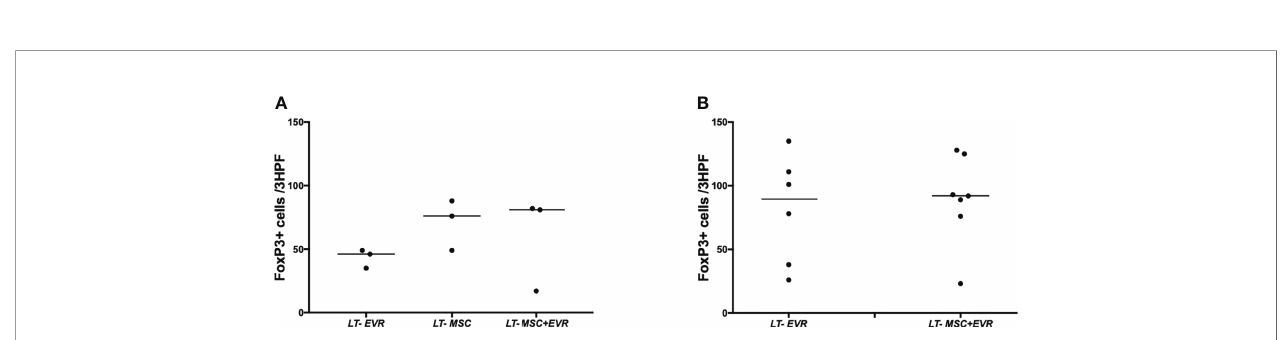
FIGURE 8 | Treg in fi ltration in the liver graft. Number of FoxP3+ cells at 40x magni fi cation (per three high power fi elds) by examining graft section of each group after immunohistochemistry on POD 9 (A) and at the end of the experiment (B)